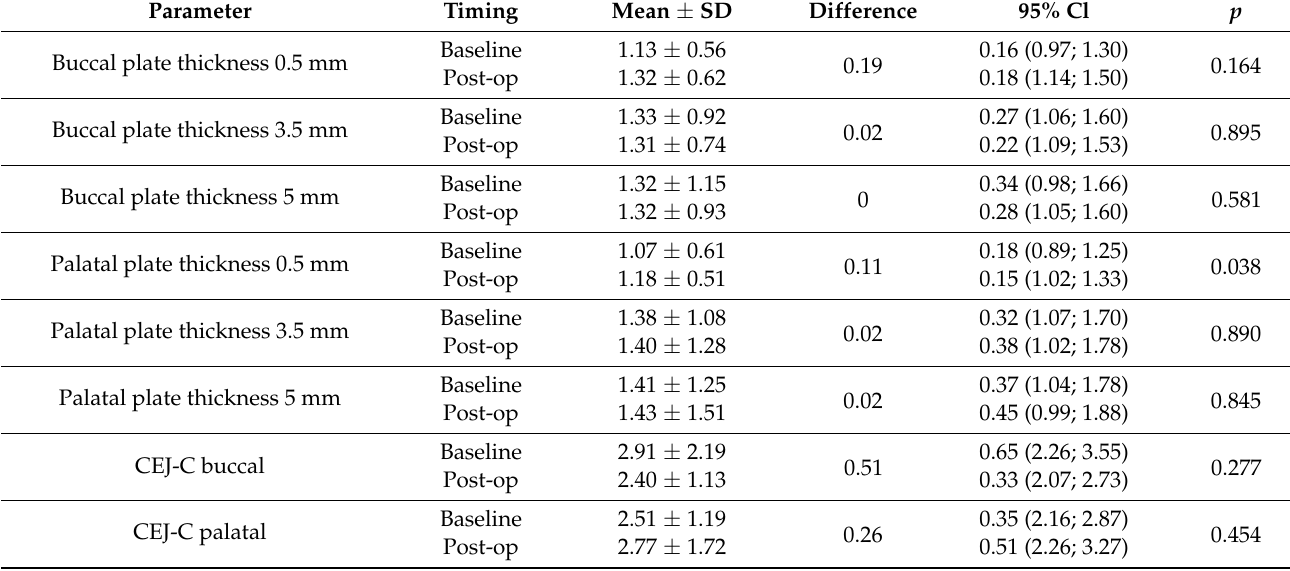
Table 8. Distribution of CBCT parameters for distal molars’ roots before and after orthodontic treatment.